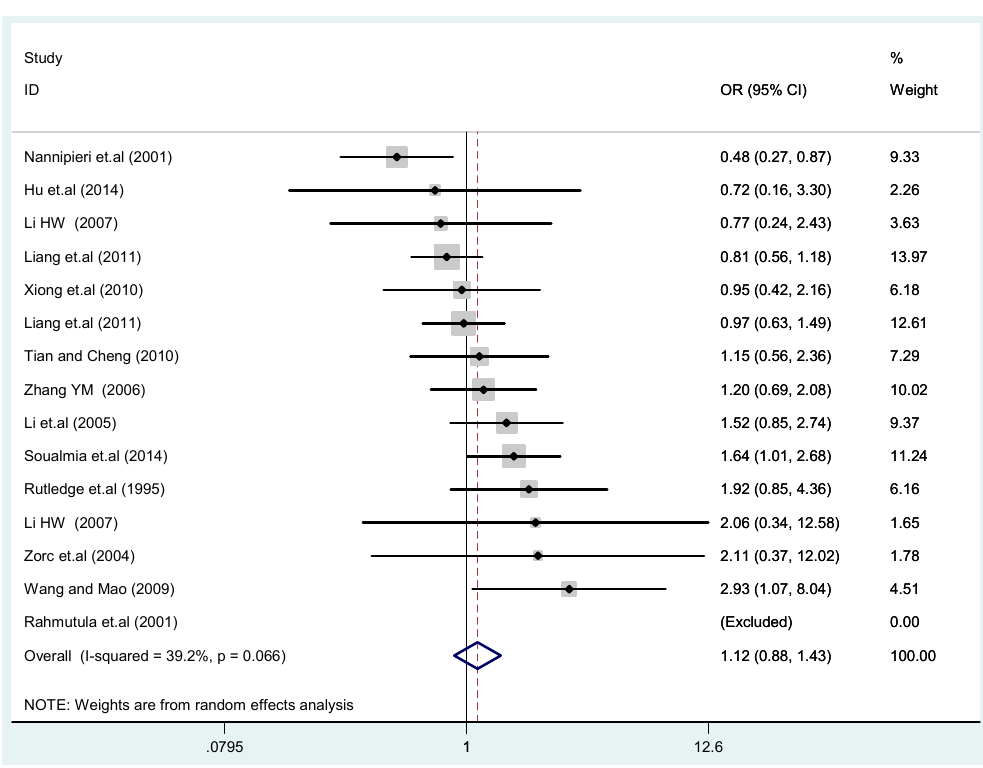
Figure 4. Forest plot of overall population of T2238C co-dominant model-2 (CC vs. TT).